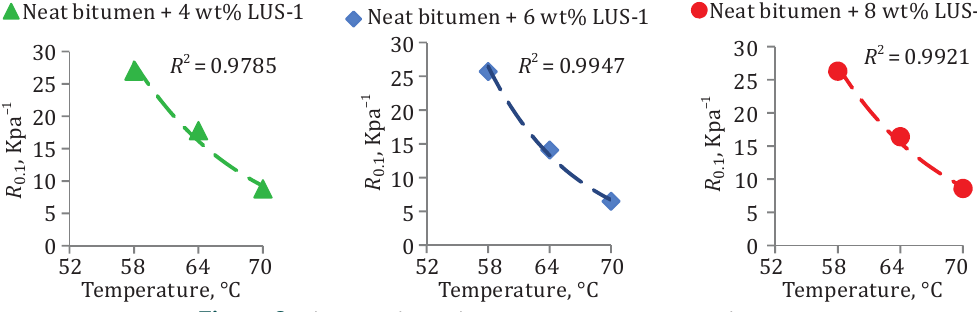
Figure 8. The correlationbetween temperature and R 0.1